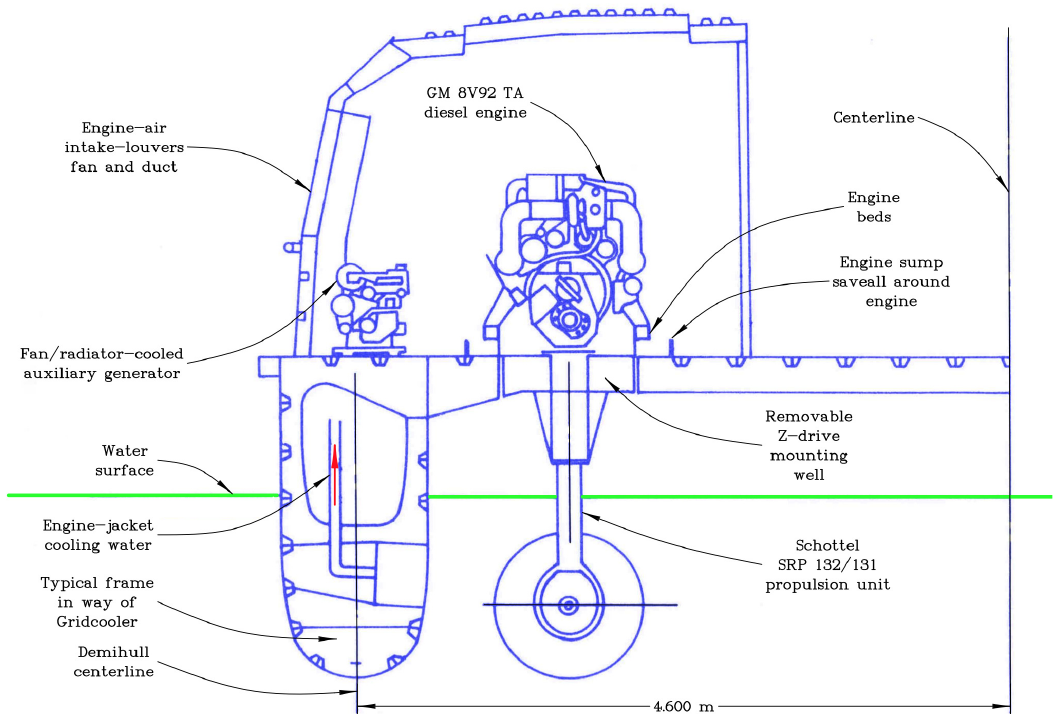
Figure 4. Section of machinery